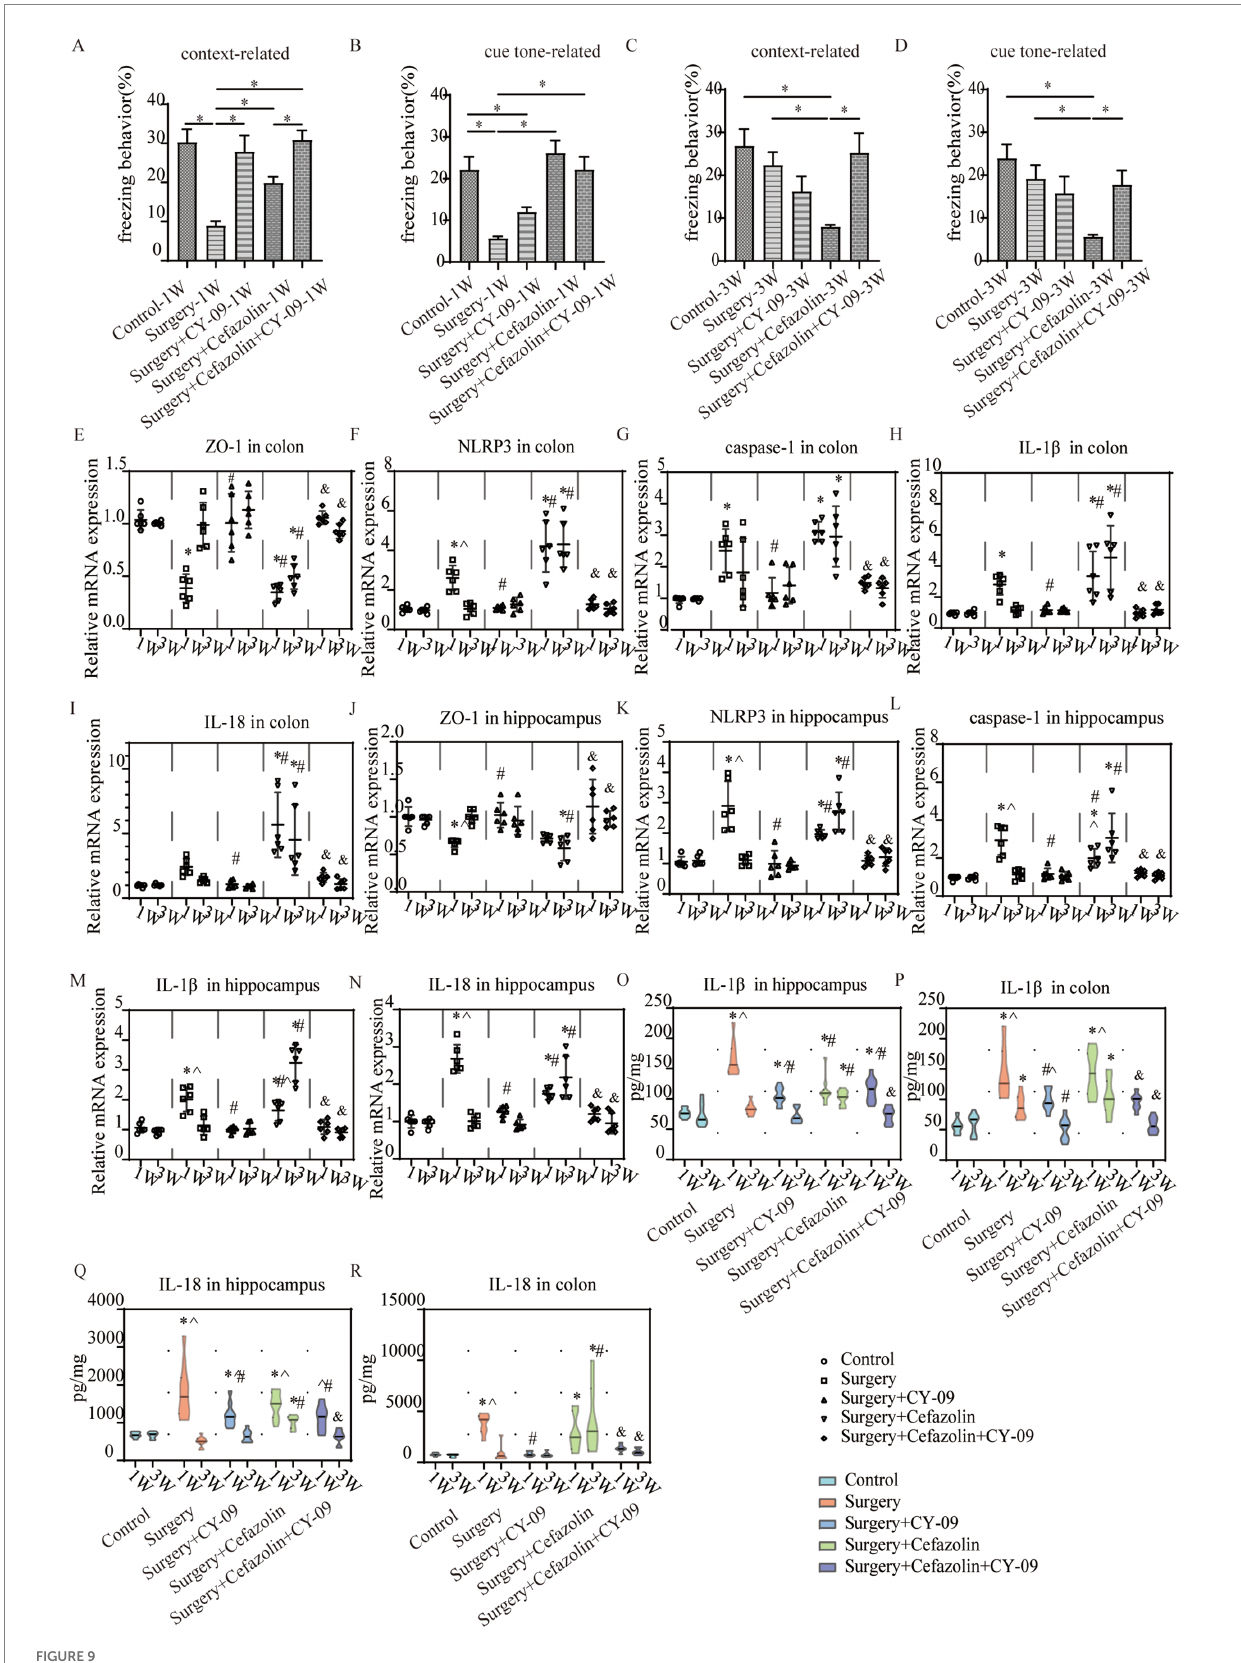
FIGURE 9 The CY-09 administration effectively improved perioperative cognitive dysfunction, inhibited perioperative inflammatory response, and protected barrier permeability in the colon and hippocampus. (A–D) CY-09 improved context-related freezing behavior (q = 6.952, p = 0.0001) decreased by surgery/anesthesia stress at 1 week. While at 3 weeks after surgery, CY-09 also improved context-related (q = 5.112, p = 0.0065) and cue